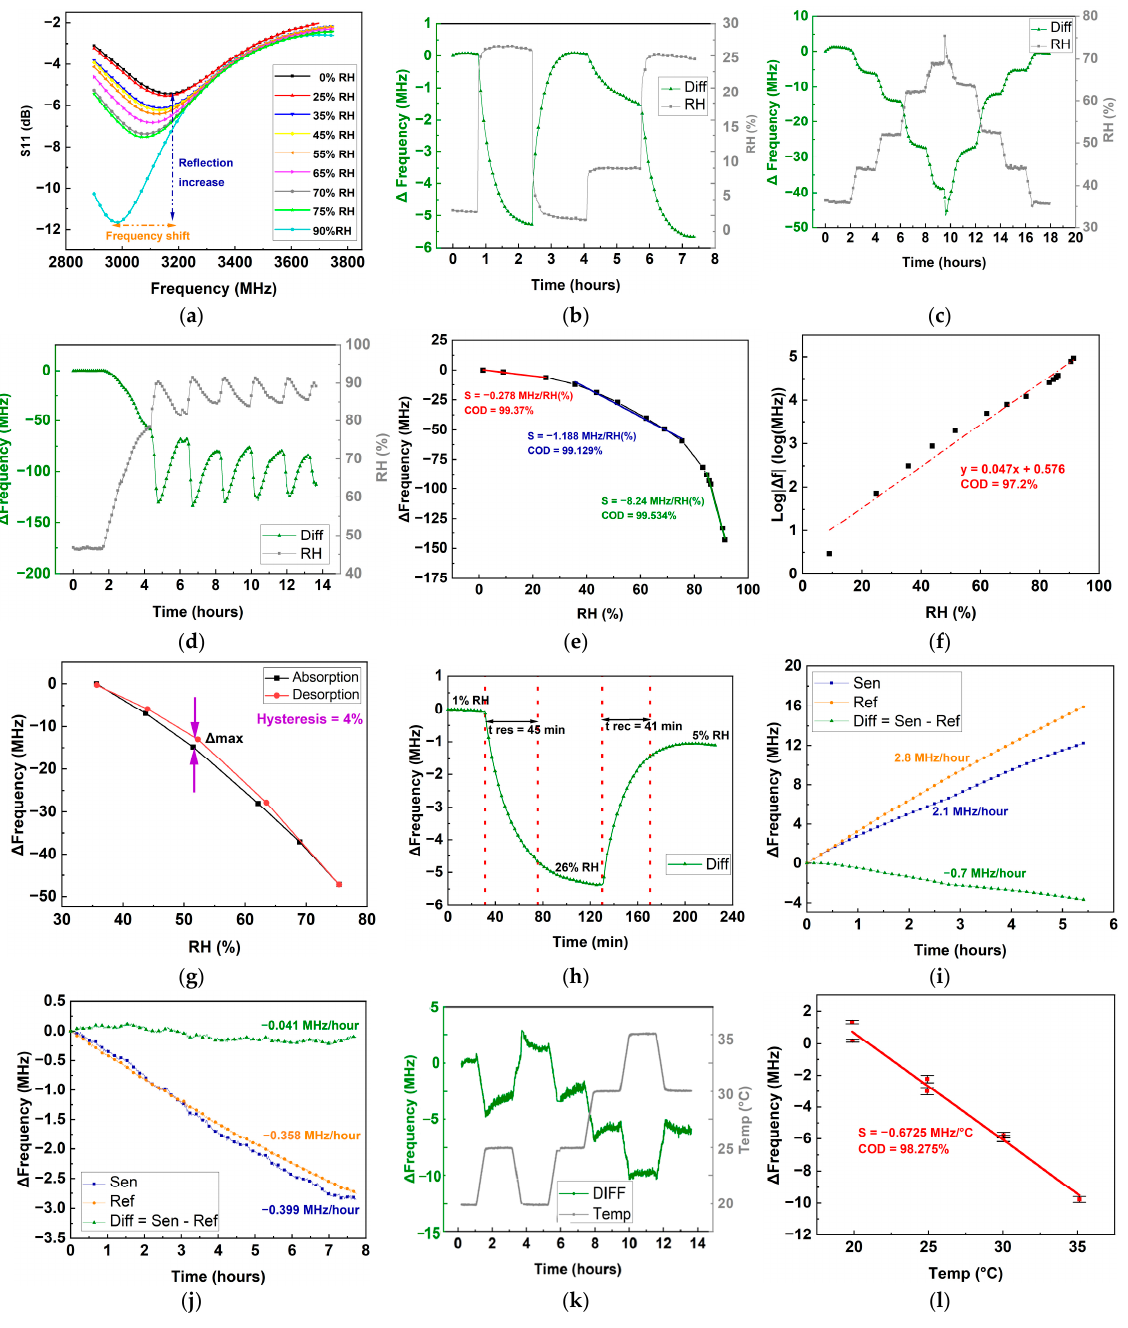
Figure 6. Sample 1 RH and temperature-sensing performances: ( a ) coated resonator static frequency response when exposed to 0–90% RH, ( b ) dynamic differential frequency response under 0–30% RH, ( c ) dynamic differential frequency response under 35–75% RH, ( d ) dynamic differential frequency response under 80–90% RH, ( e ) sensor RH calibration curve of differential frequency response with its different sensitivities and CODs, ( f ) sensor log differential frequency response, ( g ) hysteresis curve of the differential frequency response in the range 35–75% RH, ( h ) sensor response/recovery times at 20 ◦ C, ( i ) sensor desorption stabilisation when exposed to N 2 at 20 ◦ C, ( j ) sensor sorption drift when exposed to constant 45% RH, ( k ) sensor dynamic frequency response to temperature in the range 20–35 ◦ C at 40% RH and ( l ) sensor temperature calibration curve with its sensitivity and COD at 40%